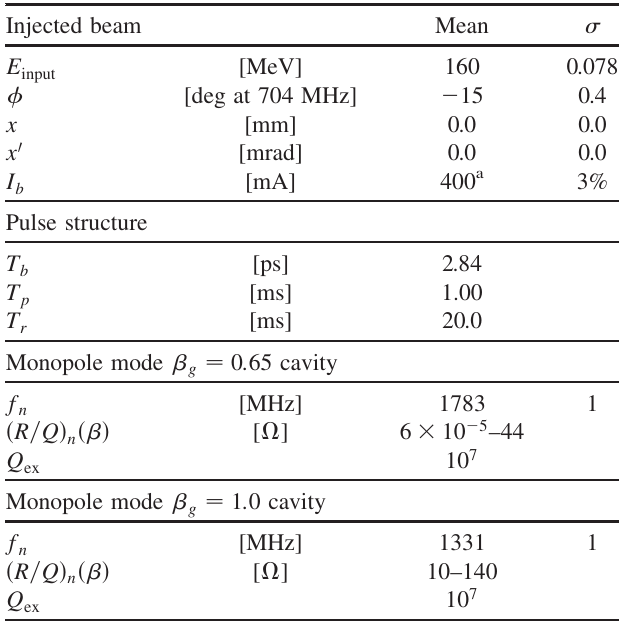
TABLE VI. Default settings used in all longitudinal beam dynamics simulations.